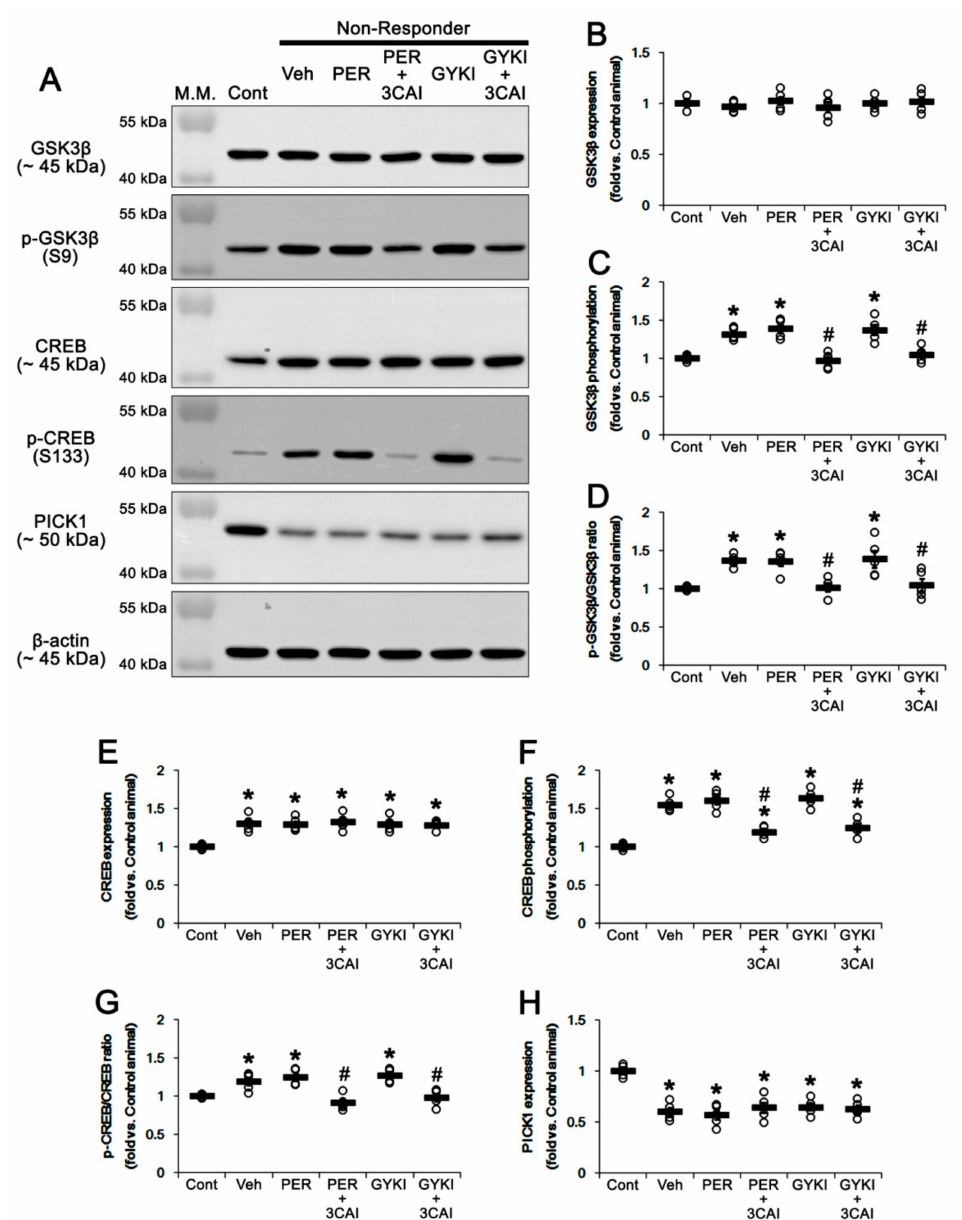
Figure 9. The effects of 3CAI co-treatment with perampanel (PER) and GYKI 52466 (GYKI) on expression levels of GSK3 β , CREB, and PICK1 and the phosphorylation levels of GSK3 β and CREB in non-responders. ( A ) Representative images for Western blot of total GSK3 β , CREB, and PICK1 levels and the phosphorylation levels of GSK3 β and CREB. ( B – H ) Quantifications of GSK3 β ( B ), p-GSK3 β S9 ( C ), p-GSK3 β S9/GSK3 β ratio ( D ), CREB ( E ), p-CREB S133 ( F ), p-CREB S133/CREB ratio ( G ), and PICK1 ( H ) in the hippocampal tissues. Open circles indicate each individual value. Horizontal bars indicate mean value. Error bars indicate SEM ( *, # p < 0.05 vs. control (Cont) and vehicle (Veh)-treated animals, respectively; one-way ANOVA with post hoc Bonferroni’s multiple